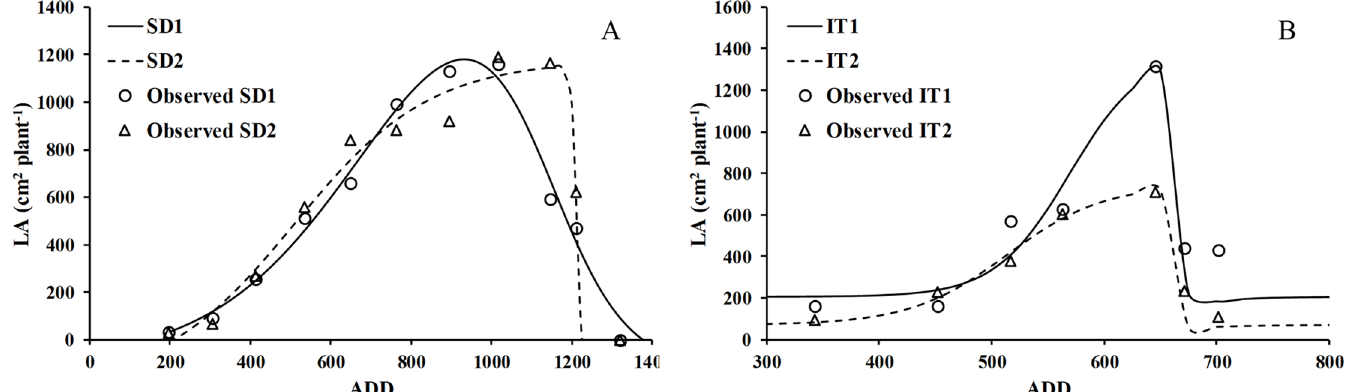
Fig 5. Evolution of leaf area (cm 2 plant -1 ) throughout the chia crop cycle (points). Curves were adjusted using a double logistic function (lines) as a function of accumulated degree days (ADD) for sowing date (A) and water availability (B) in chia plants established in Antumapu and Intihuasi, respectively.